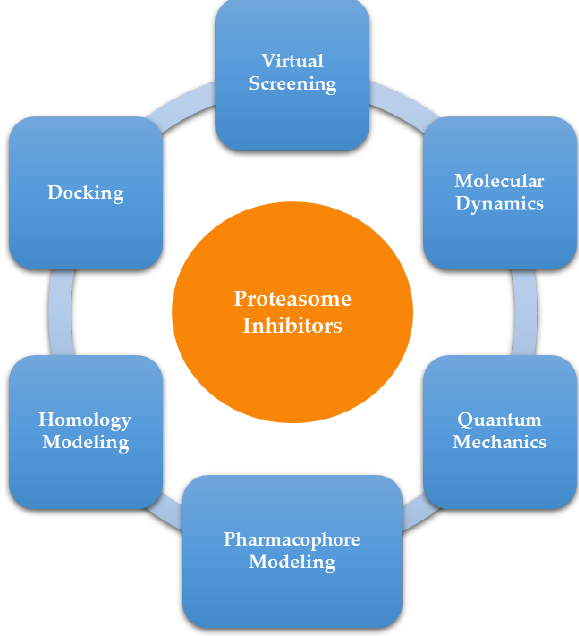
Figure 6. Some Computer-Aided Drug Design (CADD) methodologies used in the discovery and study of proteasome